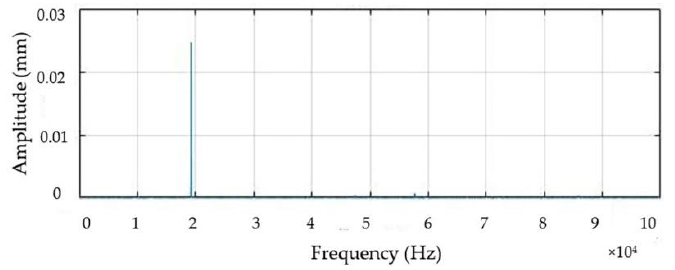
Figure 16. Frequency domain diagram obtained after fast Fourier transform.